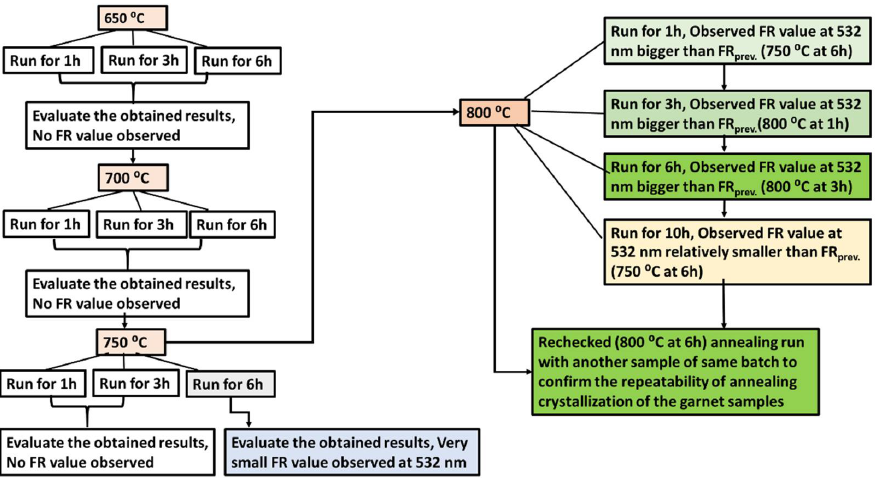
Figure 1. Schematic diagram of annealing process optimization experiments conducted to find the most suitable annealing regimes (in terms of both the maximum process temperature and crystallization process duration) for this type of garnet layers.